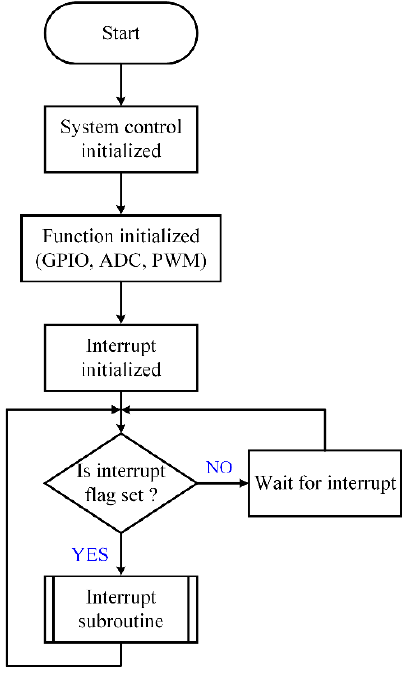
Figure 11. Flow chart of the main program.